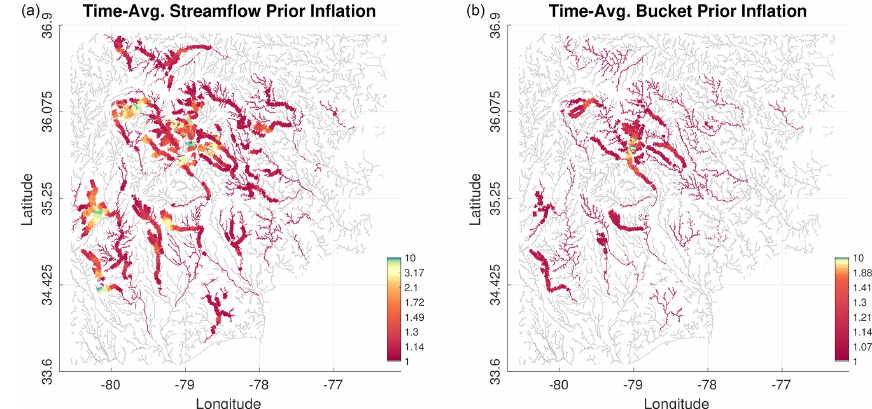
Figure 10. Time-averaged prior inflation for streamflow (a) and the bucket (b) resulting from PP-inf run. The inflation is averaged over all estimates between 12 and 18 September. Color (log scale) and line thickness both indicate the inflation value. Gray reaches have an inflation value of 1.